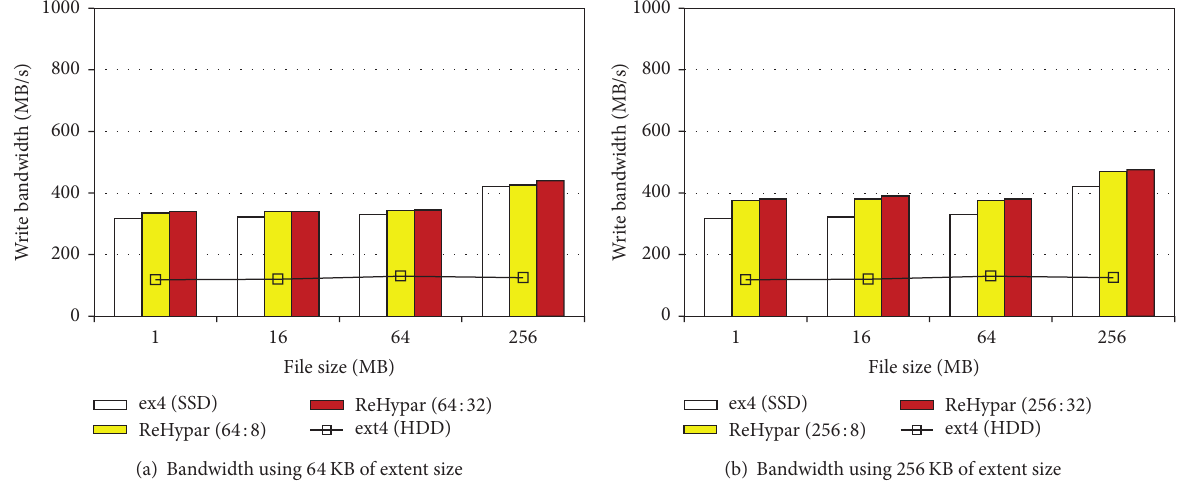
Figure 4: ReHypar write bandwidth as compared to ext4.